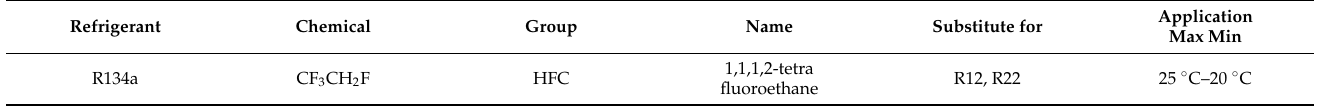
Table 1. Overview of refrigerant R-134a [49].